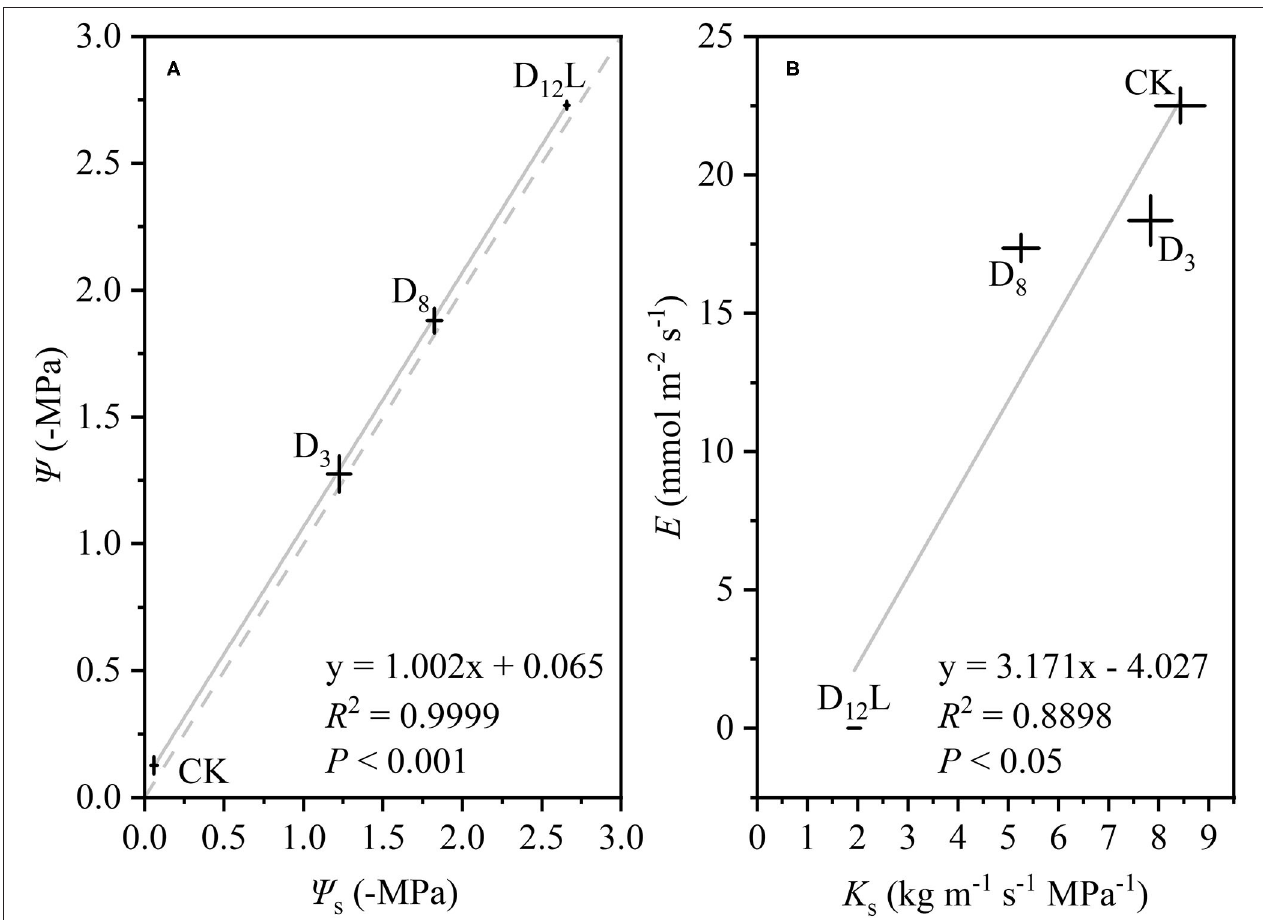
FIGURE 5 | The relationship between soil water potential ( Ψ s , –MPa) and stem water potential ( Ψ , –MPa), (A) between stem-specific hydraulic conductivity ( K s , k g m − 1 s − 1 MPa − 1 ) and transpiration rate ( E , mol m − 2 s − 1 ), (B) in CK, D 3 , D 8 , and D 12 L. CK, control group; D 3 , mild drought group; D 8 , moderate drought group; D 12 L, lower part of the severe drought group. The data is represented by the mean ± 1 SE and n = 10. Light gray line stands for the linear regression of the points, and light gray dash line stands for Ψ = Ψ s